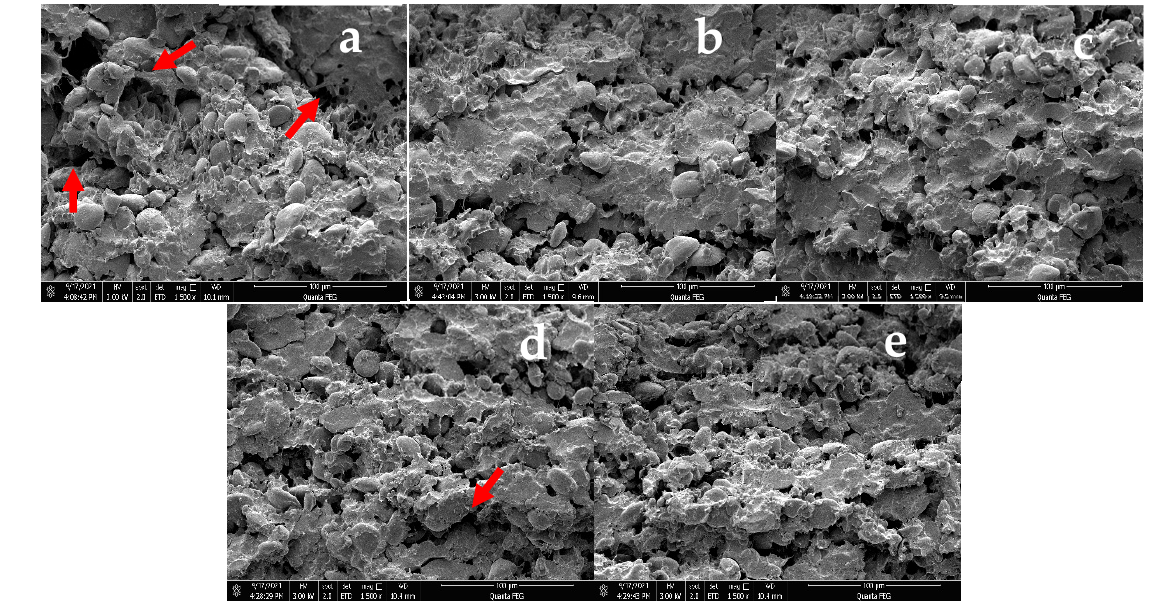
Figure 4. SEM images of noodles with different additives: ( a ) control, ( b ) 3% TF, ( c ) 0.6% SA, ( d ) 0.4% GG, ( e ) 0.4% XG. Note: The red arrows in the figure indicate that there are discontinuities in the structure and the starch is not tightly wrapped.